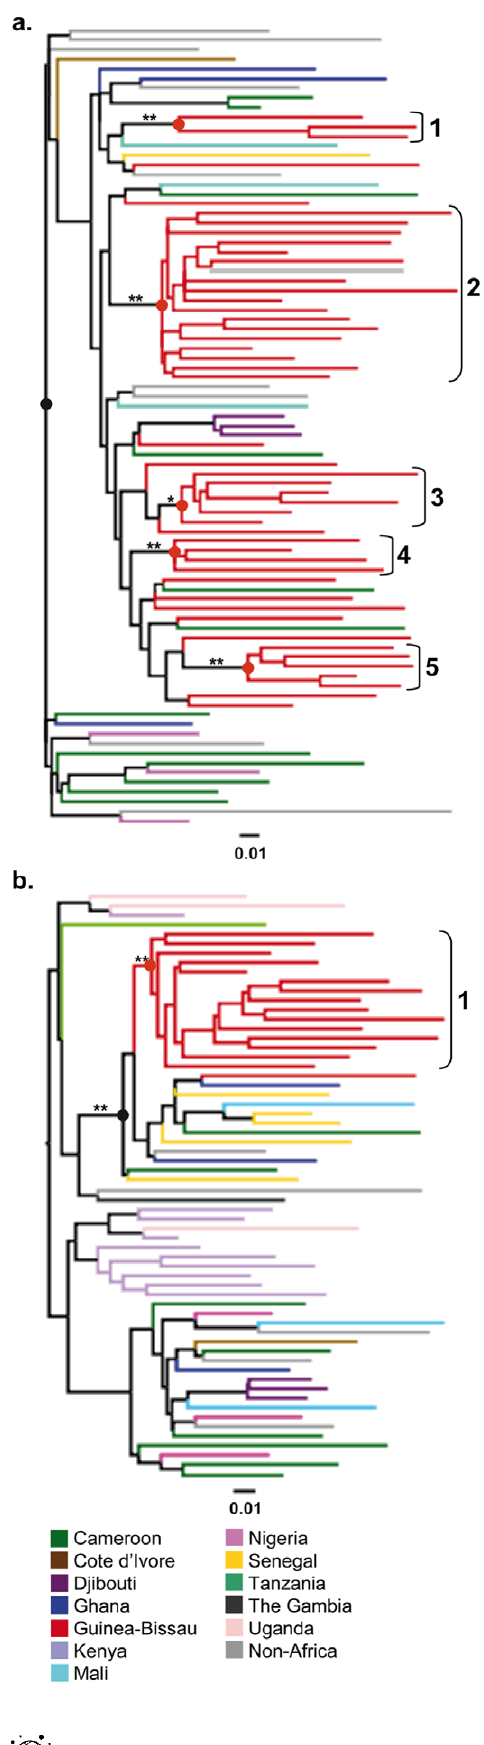
Figure 1. a–b. Determination of Guinea-Bissau-specific clusters in HIV-1 CRF02_AG and subsubtype A3 phylogenies. Maximum- likelihood trees were reconstructed based on the sequences from Guinea-Bissau together with reference sequences (A. CRF02_AG and B. subsubtype A3). The scale bar at the bottom of each tree represents 0.01 nucleotide substitutions per site. Asterisks along branches represent significant monophyletic clusters (**: Zero-branch-length test p-values , 0.001, and posterior probabilities . 95% in corresponding Bayesian analysis. *: Zero-branch-length test p-values , 0.01, and posterior probabilities . 90%). Statistically supported clusters are numbered according to appearance in tree and the corresponding tMRCA are marked with filled circles (red circles = Guinea-Bissau- specific tMRCAs, and black circles = the tMRCA of the CRF02_AG or subsubtype A3). The colours represent the country or geographic region representing the origin of each tip in the